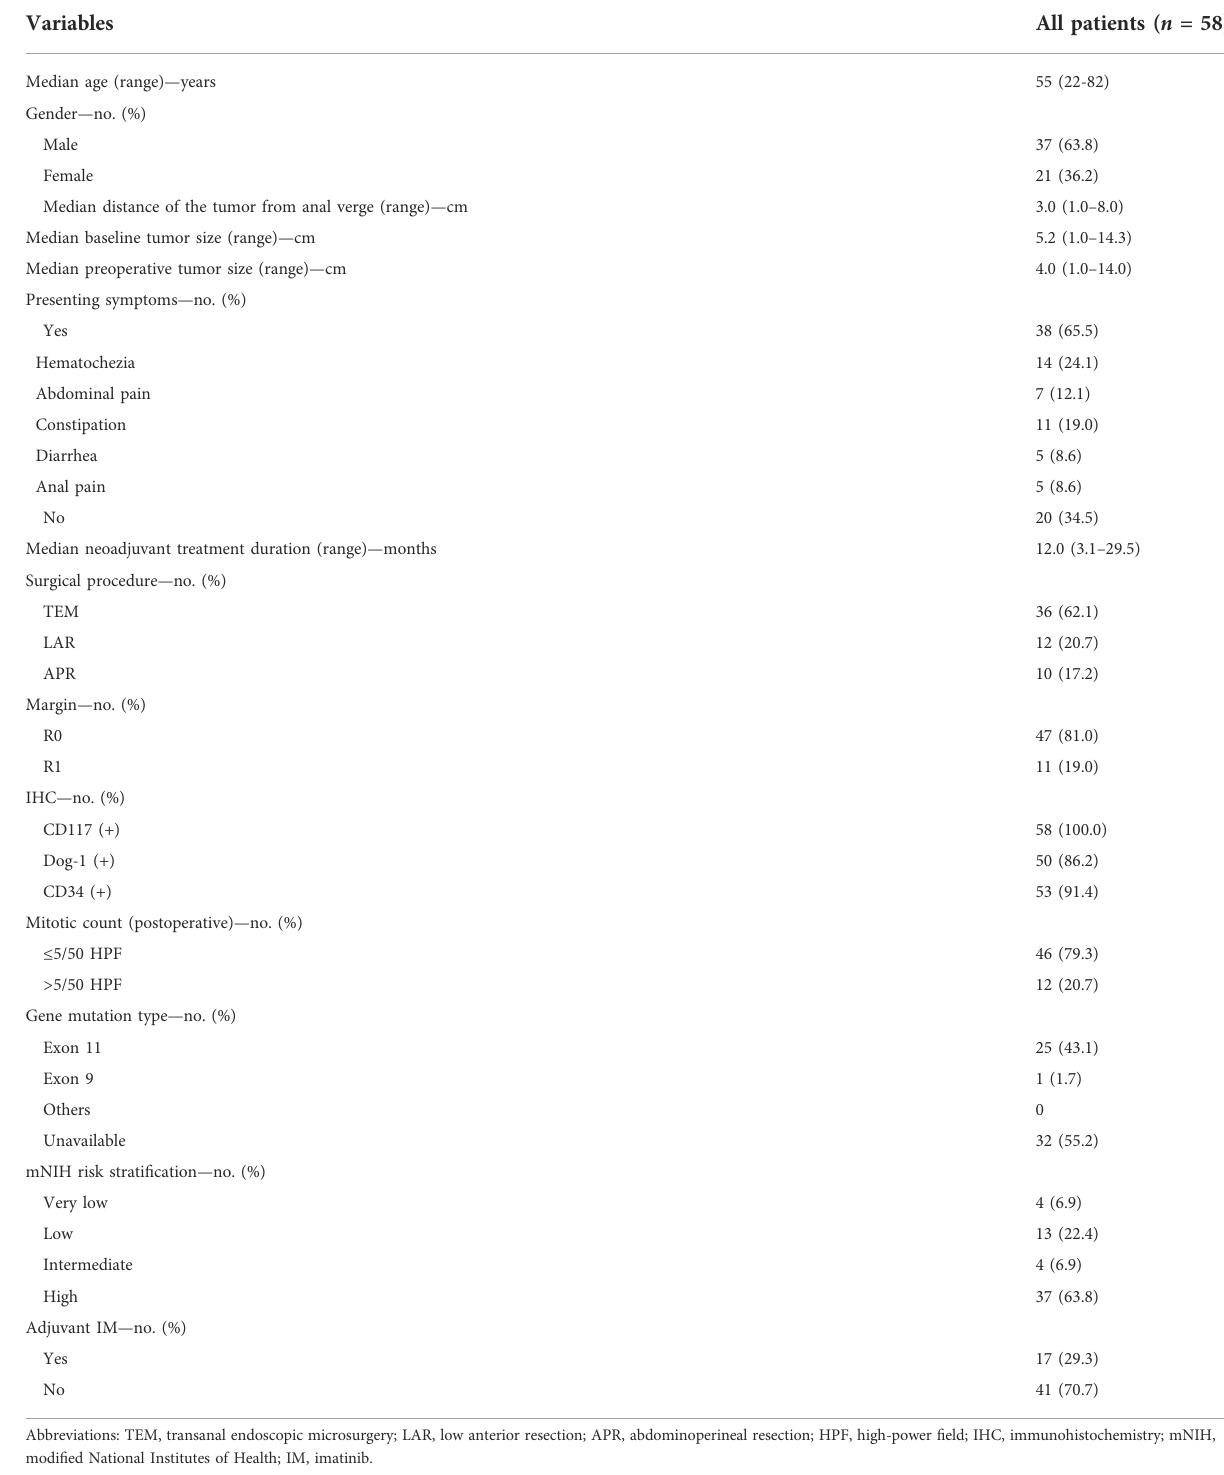
TABLE 1 Characteristics of the total patients in the